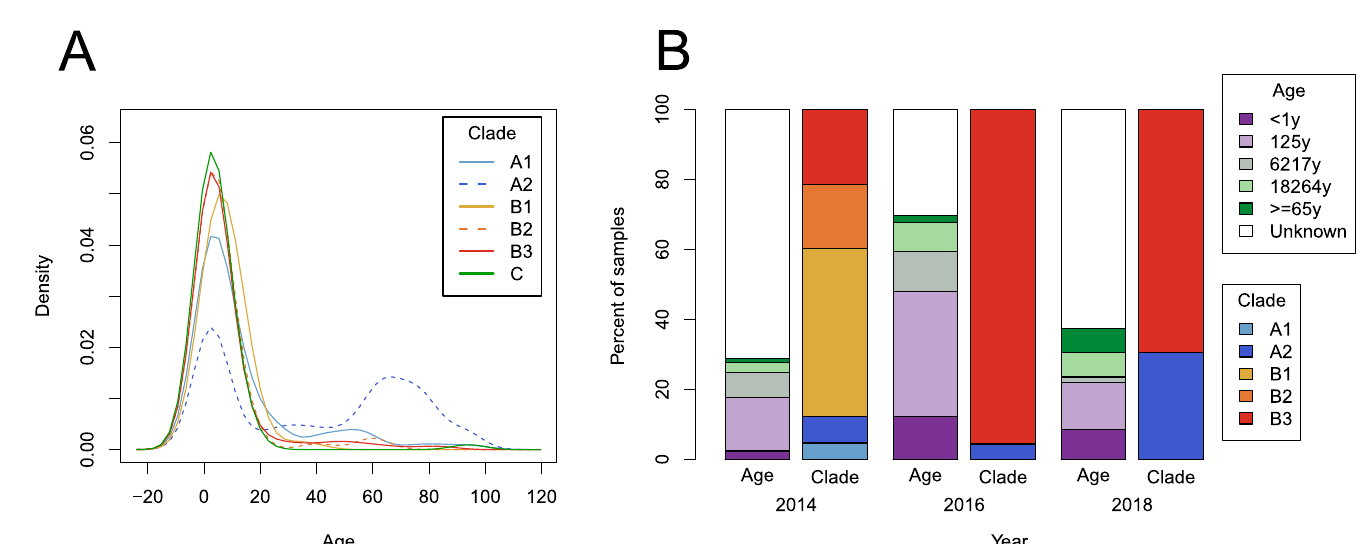
Fig 3. Age distribution of EV-D68 samples. (A) The cumulative distribution over age separated by subclade; A2 being significantly more often detected in older persons. (B) The age of patients and subclade of their sample, for samples taken during 2014, 2016, and 2018 for which ‘age range 1’ (see section D of S1 Text) was